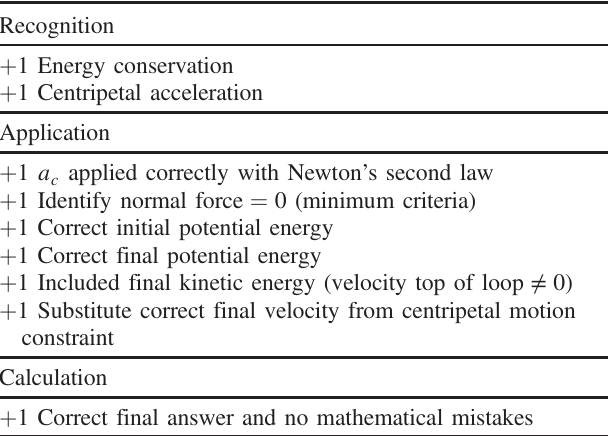
TABLE II. Scoring rubric for the target synthesis problem. 1 point was awarded for each item, for a total of 9 points.